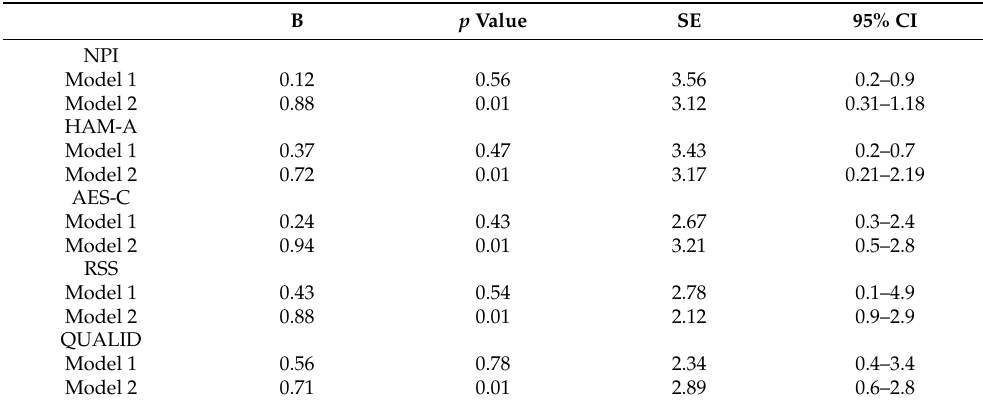
Table 7. Association between sVAD and neuropsychological variable with a multivariate linear regression analysis. B p Value SE 95% CI